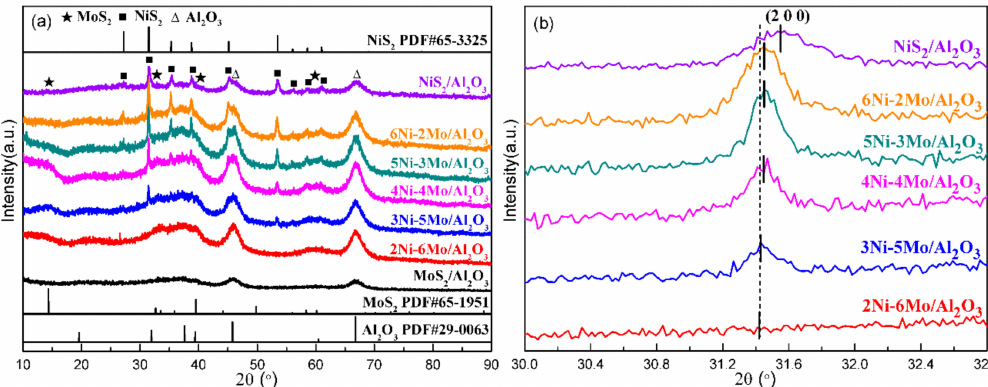
Figure 1. The XRD patterns of the Ni-Mo sulfide / Al 2 O 3 catalysts with di ff erent Ni / Mo molar ratios ( a ) scanning angle of 10–90 ◦ ; ( b ) scanning angle of 30–32.8 ◦ . Table 1. BET surface areas, particle sizes, and band gaps of the various Ni-Mo sulfide / Al 2 O 3 catalysts. BET Surface Area Particle Size Band Gap Catalyst (m 2 / g) (nm) (eV) NiS 2 / Al 2 O 3